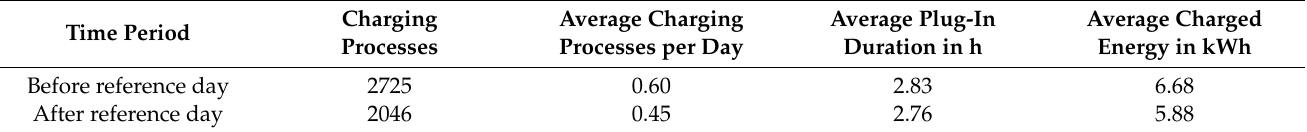
Table 7. Characteristics of the CPs within the time period around the reference